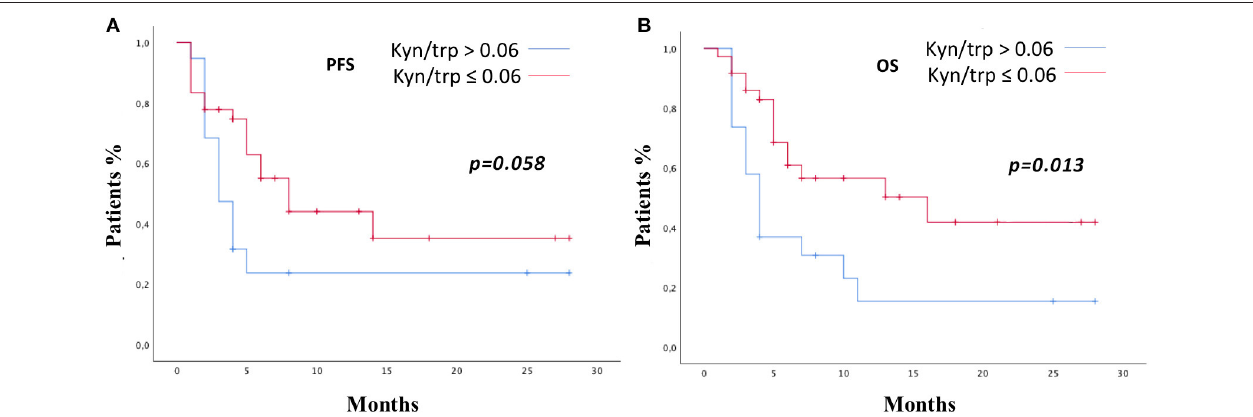
ratio is inclined to be associated with a worse survival despite